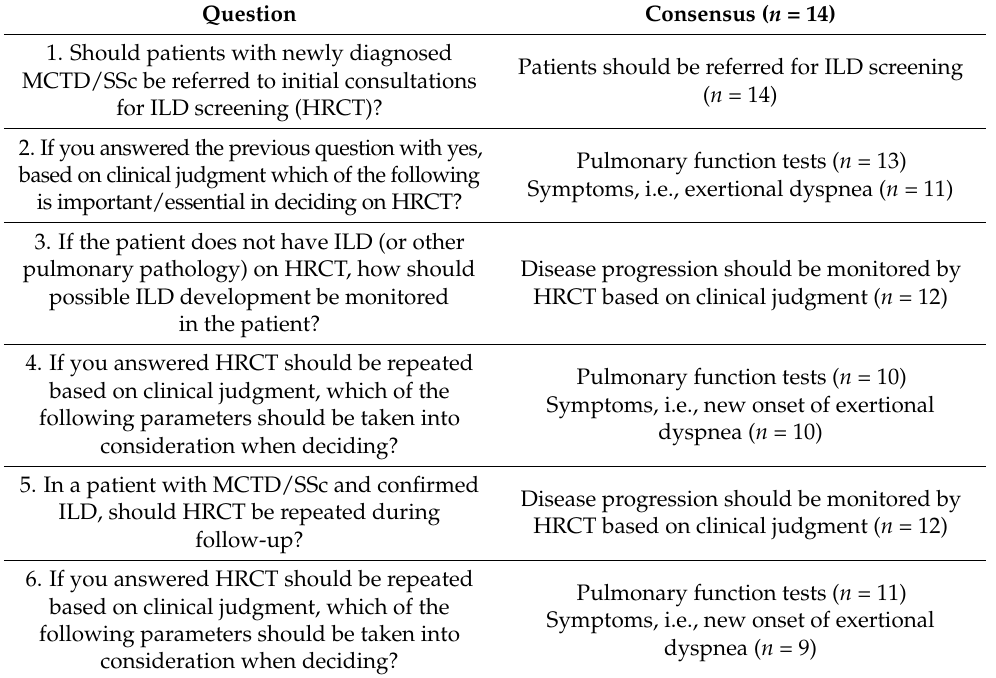
Table 1. Consensus results of the MCTD and SSc questionnaire for screening and monitoring